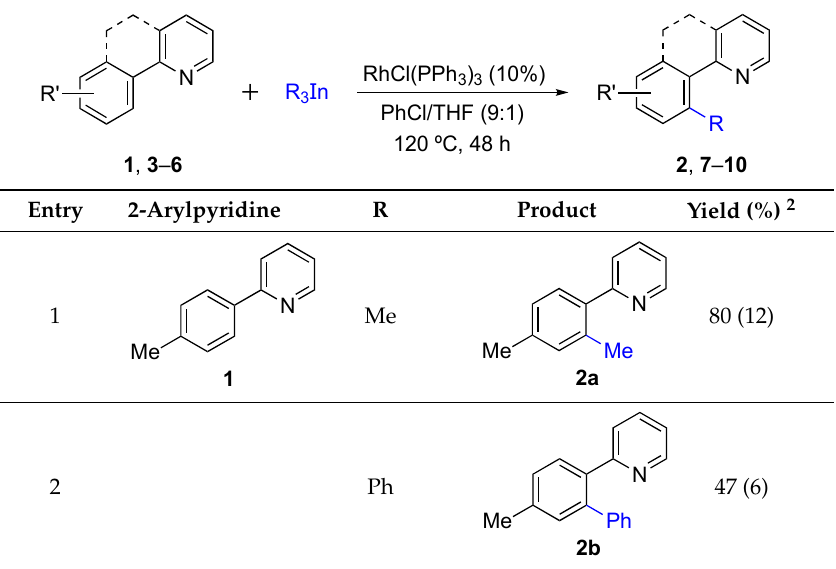
Table 2. Reaction of R 3 In with 2-arylpyridines under rhodium catalysis 1 .